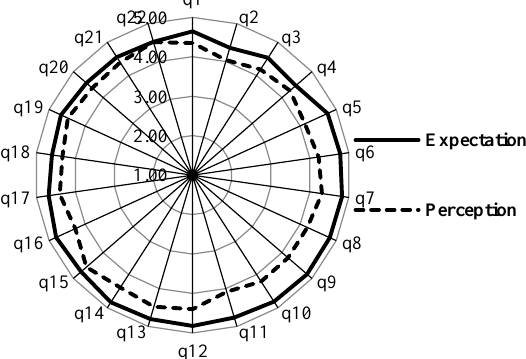
Figure 2. Expectation – Perception Gap Analysis (SERVQUAL questions) Figure 3 indicates the scatter plot of perception versus expectation means for all subjects under study. Two vertical and horizontal lines were drawn based on overall expectation and perception means, respectively; as shown, the overall mean of expectation was more than that of perception (4.7 vs. 4.3). As also seen in this figure, most case scores were set above 4; this reflects the patients’ perspective of high quality of